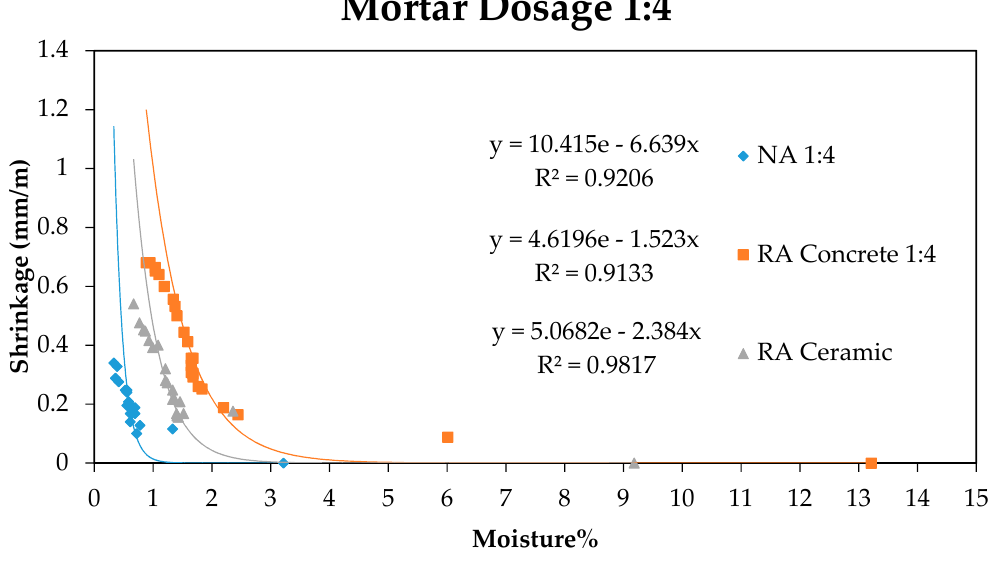
Figure 6. Relation Moisture–Shrinkage for mortars with 1:4 dosage.